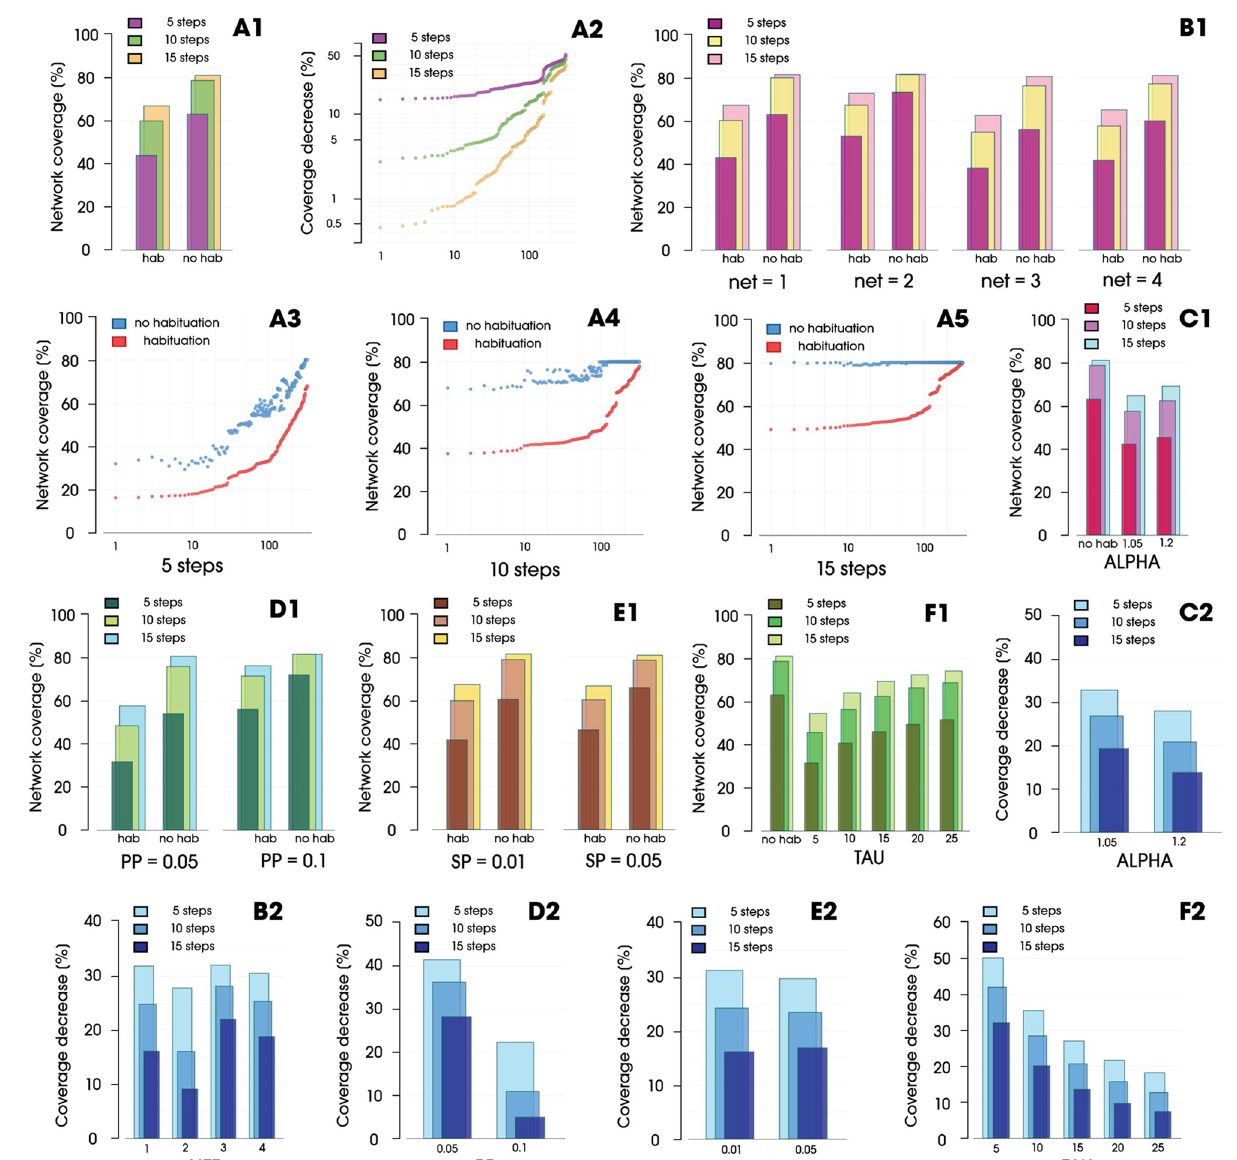
Fig 4. ( A1 ) Coverage for spreading processes with and without habituation. ( A2 ) Coverage decrease in processes with the habituation effect, compared to processes without habituation, sorted by the decrease in coverage. ( A3 -- A5 ) Distances between coverage in simulations with and without the habituation effect, with results sorted by coverage without habituation and assigned corresponding results from processes with the habituation effect. ( B1 ) Coverage for each network for spreading processes with and without habituation. ( B2 ) Decrease in coverage for each network in relation to a process without habituation. ( C1 ) Coverage for each alpha value for spreading processes with habituation compared to a process without habituation. ( C2 ) Decrease in coverage for each alpha in relation to a process without habituation. ( D1 ) Coverage for propagation probabilities for spreading processes with and without habituation. ( D2 ) Decrease in coverage for each PP value in relation to a process without habituation. ( E1 ) Coverage for each seeding percentage for spreading processes with and without habituation. ( E2 ) Decrease in coverage for each SP in relation to a process without habituation. ( F1 ) Coverage for each tau value for spreading processes with habituation in comparison with processes without habituation. ( F2 ) Decrease in coverage for each tau in relation to a process without